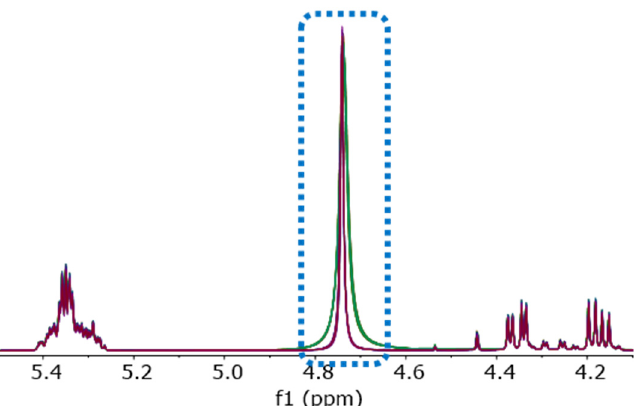
Figure 6. Superposition of 24 spectra in the range of δ H = 4.1–5.5 ppm of fat extracts of the same coffee samples. The water signal is highlighted by the blue dotted box. Solvent was mitigated (D 1 )chloroform and (D 4 )methanol (1/1, v / v ). For one set (a dozen spectra) the mitigated (D 1 )chloroform was shaken for 15 min with oven-dried sodium carbonate (green spectra), then used immediately, resulting in broader, more intensive water signals. For the other set (a dozen spectra) the (D 1 )chloroform was shaken for two hours with oven-dried sodium carbonate and allowed to stand overnight (purple spectra), resulting in narrower and weaker water signals.. 1 H-NMR spectra, 400 MHz, 290 K, referenced to δ TMS = 0.00 ppm. Signal assignments: 5.42–5.25 ppm (multiplet) triacylglycerides and unsaturated fatty acids; 4.74 ppm (singlet) water; 4.35 (doublet of doublet), 4.17 ppm (doublet of doublet) triacylglycerides.